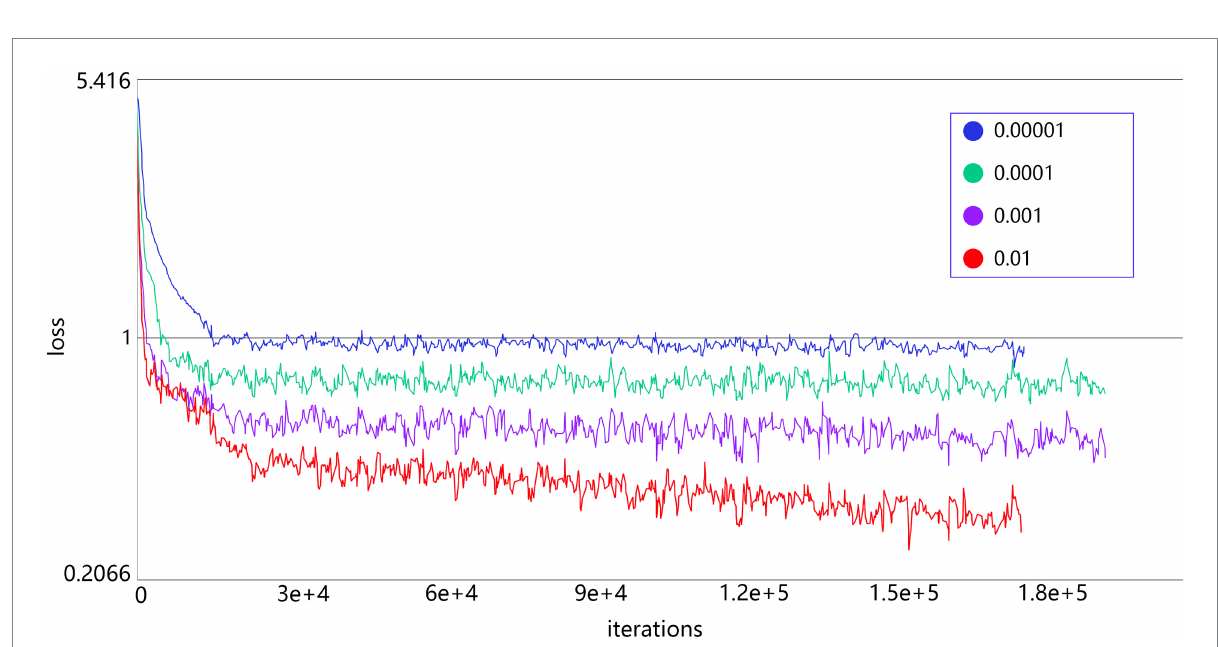
FIGURE 5 The decline of the loss curve of different learning rates during the training process.